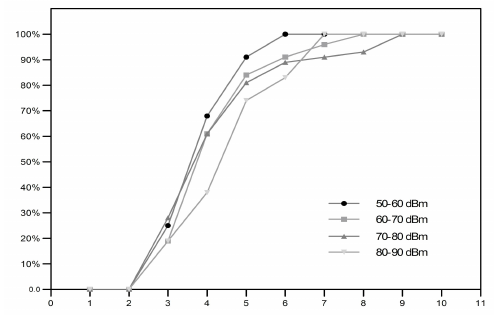
Fig. 9 The experimental CDF of RTT Figure 10. The experimental CDF of RTT